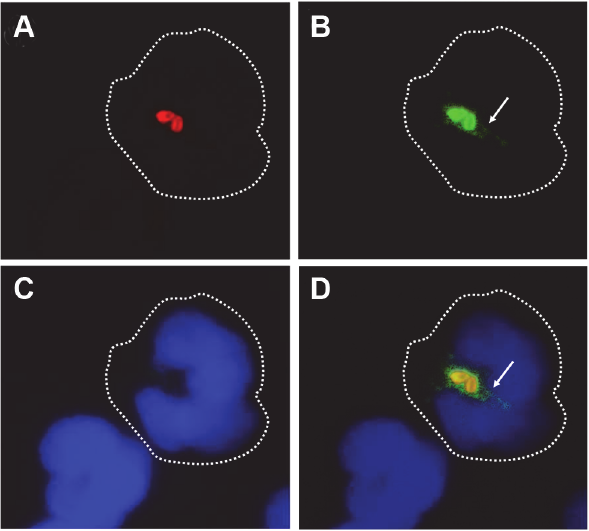
Fig 4. Br -LPS is released inside PMNs. Heparinized blood was incubated with B . abortus- RFP for one hour (MOI 2). Blood smears were fixed, stained with anti- Brucella LPS FITC (green) and mounted with ProLong Gold Antifade Reagent with DAPI. (a) B . abortus- RFP, (b) IgG-FITC anti- Brucella LPS staining, (c) PMN DAPI staining and (d) merged images. Shed Brucella LPS (white arrow) is pointed. Representative PMNs with DAPI-stained nuclei and intracellular B . abortus were photographed under the microscope using the appropriate color filter channel. Images were cut from microscope field, contrasted and saturated using Hue tool to obtain suitable color separation. Images were then merged using Adobe Photoshop 8 program. Microscope images are at 1000 ×